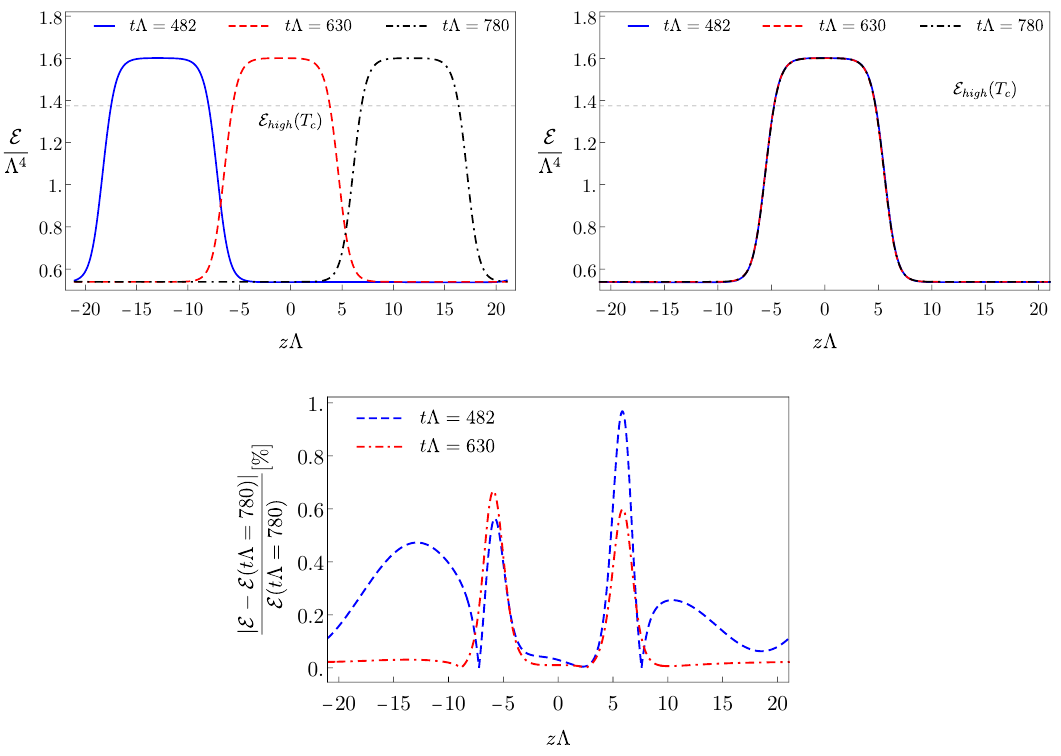
Figure 5 . (Left) Snapshots of the energy density at late times for the same initial state as in figure 3. (Right) The same profiles shifted by an appropriate constant. (Bottom) Relative difference between the profiles.